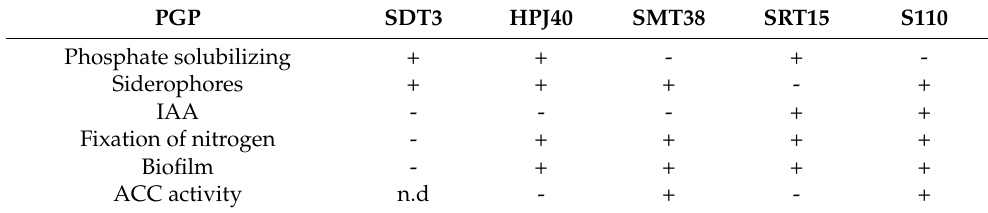
Table 1. Biofertilizer bacterial strains’ PGP properties. PGP